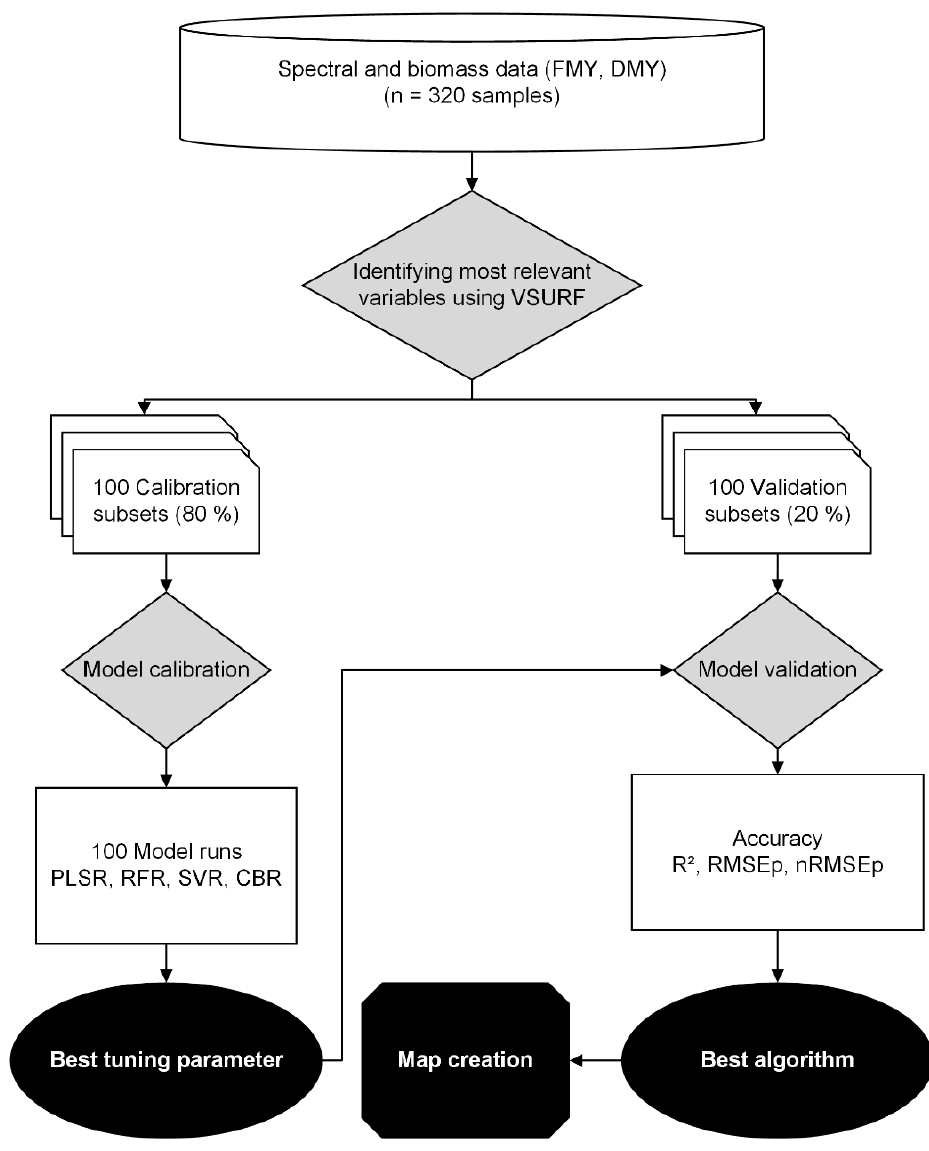
Figure 3. Workflow describing the successive steps of the analysis. ML methods were employed due to their ability to handle multicollinear data, such as the contiguous bands of hyperspectral data. The following well established and fre- quently used ML methods were evaluated for their modeling performance: partial least squares regression (PLSR), support vector regression (SVR), random forest regression (RFR) and Cubist regression (CBR). PLSR is an algorithm searching for a set of latent var- iables, which represent the covariance between the explanatory variables (i.e., selected waveband) and the response variables (i.e., biomass) best. Latent variables are only added to the model if the error is reduced. The maximum number of latent variables was limited to 20 to reduce the effect of overfitting. SVR is a kernel-based statistical approach, which uses a radial basis function to fit the data to a hyperplane [29]. SVR is beneficial for fitting complex non-linear data. The optimal model was identified using a systematic grid search, tuning the cost and sigma parameter [30]. RFR, a tree-based ensemble learning technique, combines the information from many variables. In this study, the number of trees was kept at 500 [31] independent decision trees [32]. For identifying the optimal model, the